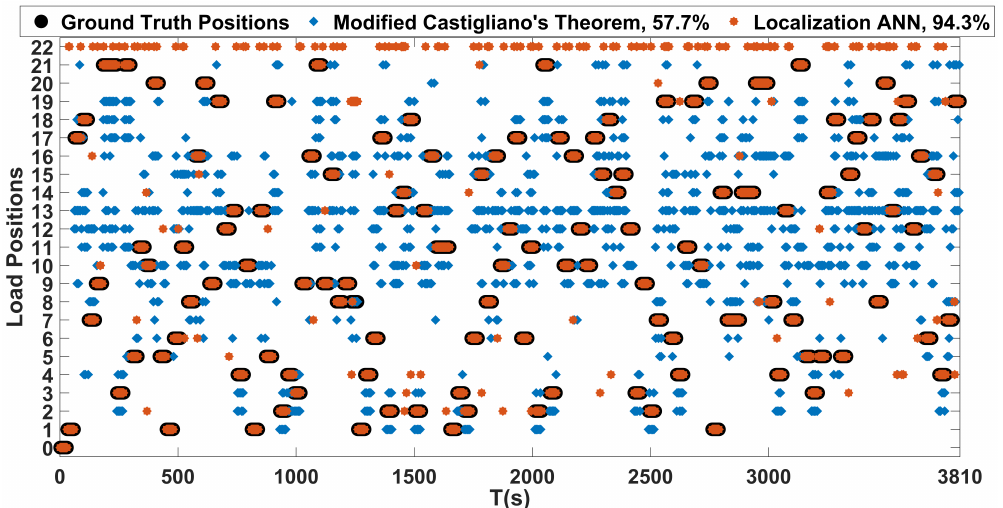
Figure 15. Position predictions based on the proposed localization ANN and modified Castigliano’s theorem, evaluated on the test